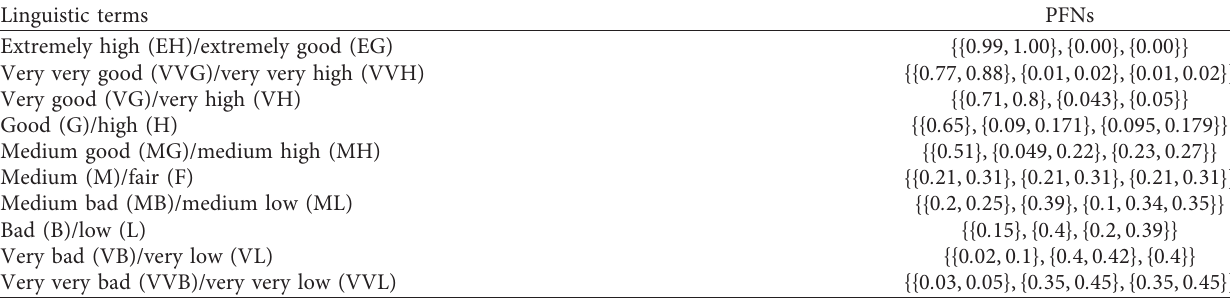
Table 2: Linguistic terms for rating the importance of alternatives.